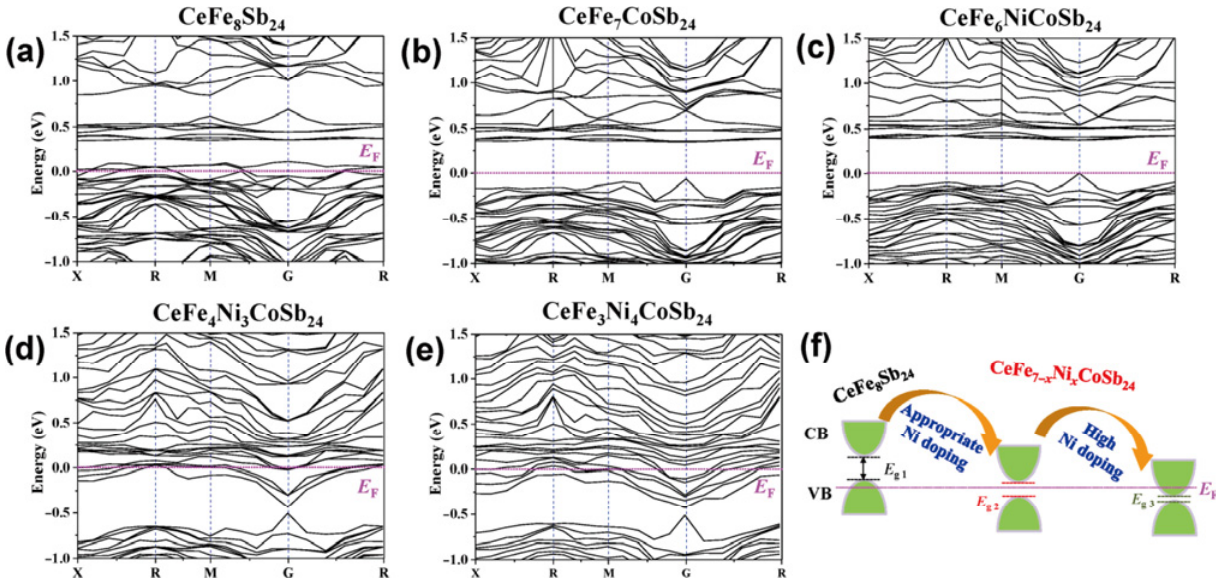
Fig. 11 Band structures of (a) CeFe 8 Sb 24 , (b) CeFe 7 CoSb 24 , (c) CeFe 6 NiCoSb 24 , (d) CeFe 4 Ni 3 CoSb 24 , and (e) CeFe 3 Ni 4 CoSb 24 . (f) Schematic of band gap reduction after Ni doping. The horizontal dashed lines represent Fermi levels ( E F ) of the